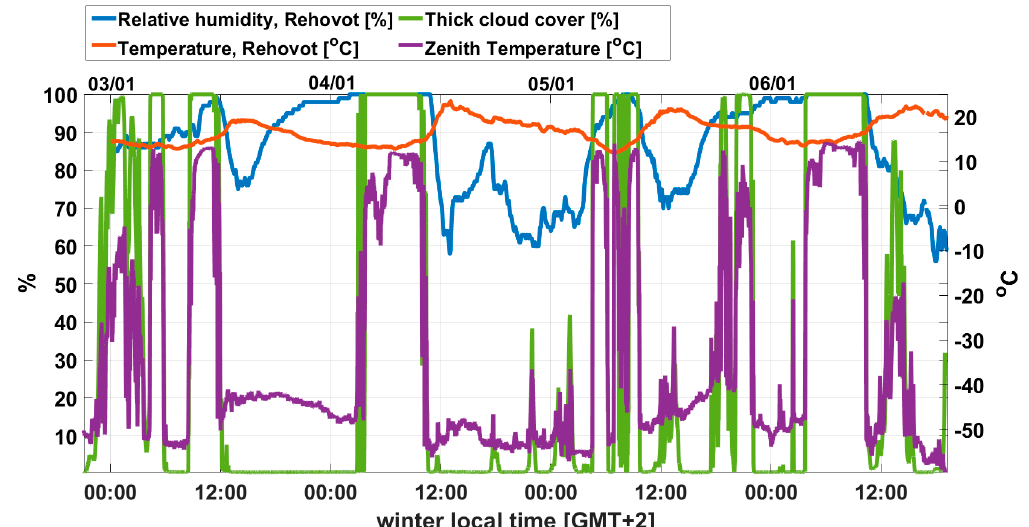
Figure 9. Relative humidity and air temperature along with the zenith temperature and thick cloud cover, during the January 2021 event, taken from “Rehovot” station. The X-axis time label denotes time- noon or midnight/date between 3–7 January 2021.